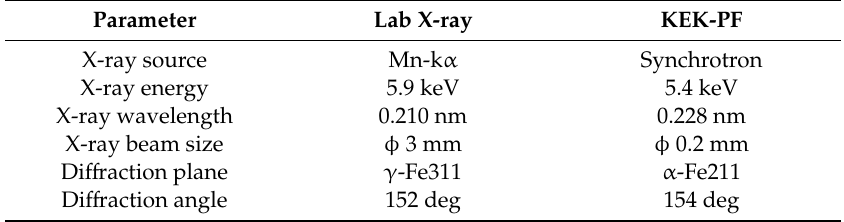
Table 4. Conditions and parameters for residual stress (RS) measurement by XRD.